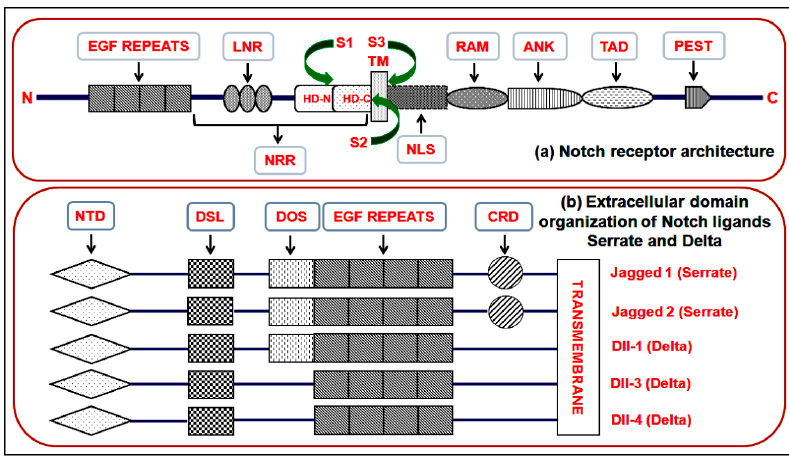
mediated by matrix metalloproteinases (MMPs) (ADAM10 / ADAM17). The TM region is followed by the most crucial part of the receptor—Notch intracellular domain (NICD). This region is made up of the nuclear localization sequence (NLS), RBPJ-associated molecule (RAM) domain, six to seven ankyrin (ANK) repeats, transcription activation domain (TAD) and PEST (Pro–Glu–Ser–Thr) domain. S3 is the site for γ -secretase-mediated cleavage that generates the NICD for nuclear transport. (b) Extracellular domain organization of Notch ligands Serrate and Delta: The N-terminal domain (NTD) is followed by the Delta–Serrate–LAG-2 (DSL) protein domain and Delta and OSM-11 DOS domain. DOS domains are not present in Dll-3 and Dll-4. Following DOS (Delta and OSM-11-like proteins), domains have varying numbers of EGF repeats. The Serrate ligands additionally have a cysteine-rich domain (CRD) that distinguishes serrate ligands from their Delta